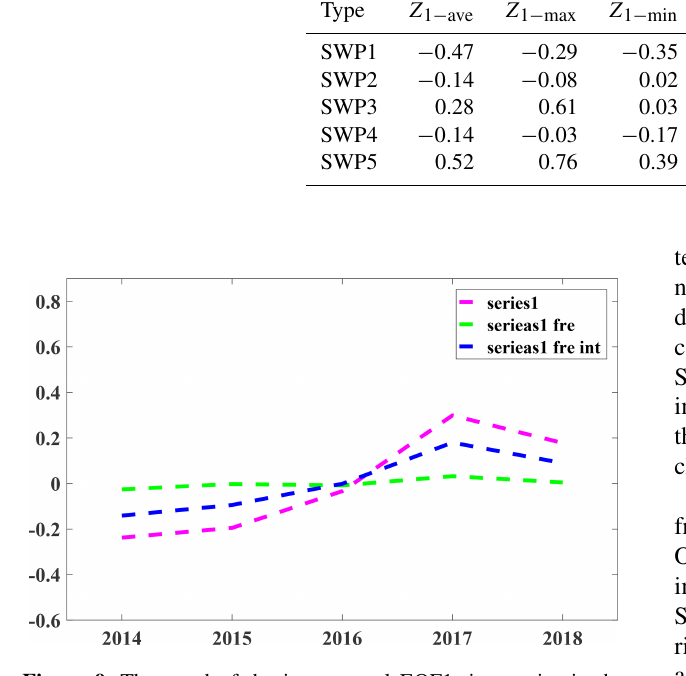
Figure 9. The trend of the inter-annual EOF1 time series in the warm seasons. The pink curve represents the original inter-annual EOF1 time series in the warm seasons, the green line represents the reconstructed EOF1 time series only accounting for the frequency variation in SWPs and the blue line represents the reconstructed one, accounting for both the frequency and the intensity variations in